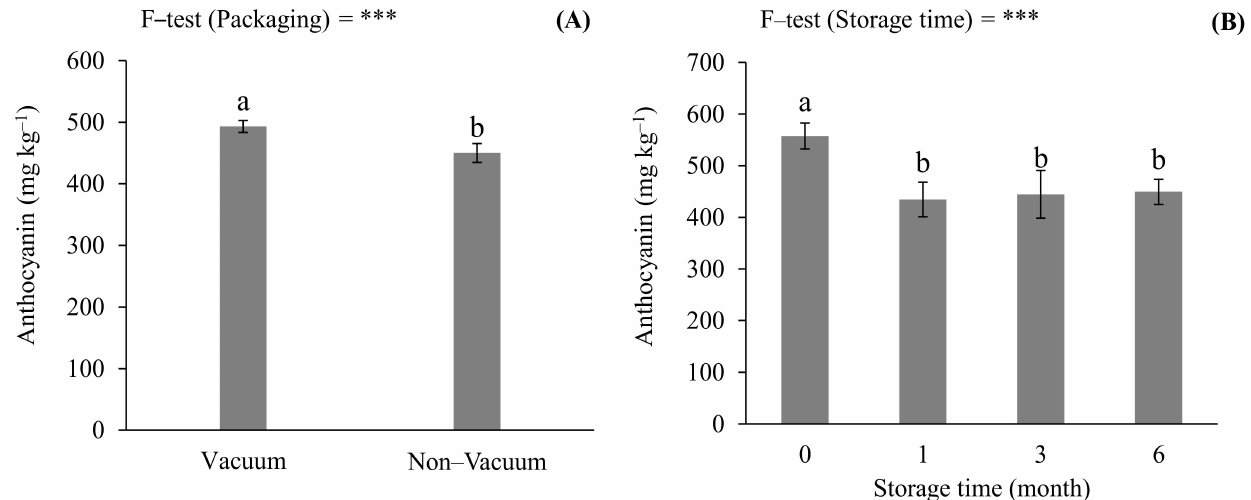
Figure 3. Anthocyanin concentration of the high-anthocyanin PES variety stored in vacuum and non-vacuum packaging ( A ) and after storage for six months ( B ). Data were analyzed by F-tests (*** p < 0.001). Different letters indicate least significant differences ( p < 0.05). The values of anthocyanin concentration are expressed as mean ± SD ( n = 4).